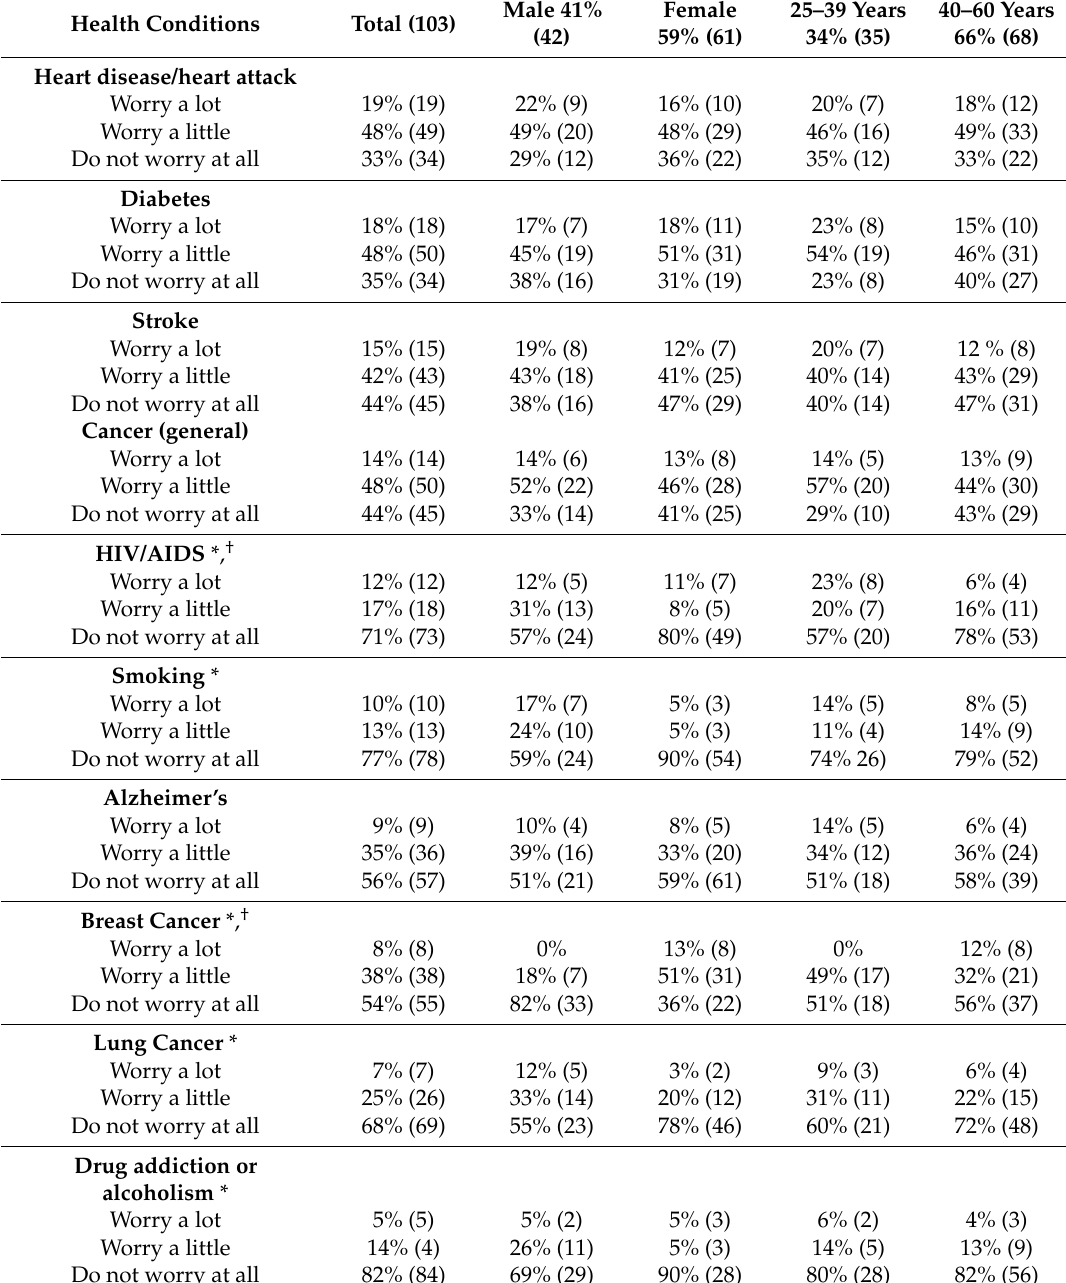
Table 3. Degree of worry about developing a health condition among African American focus group participants by gender and age cohort [ n = 103; % ( n